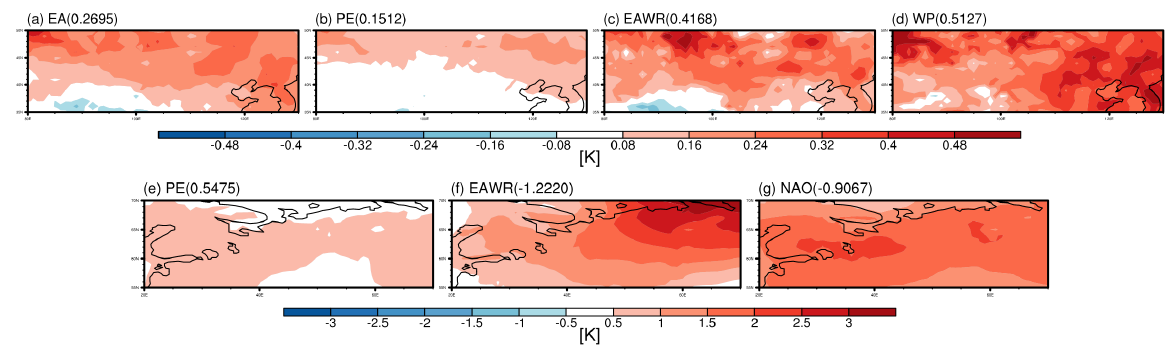
Figure 4. The spatial distribution of surface temperature (T2m, K) regressed on the principal com- ponent (PC) time series of the most related teleconnection patterns to the East Asia (EA) domain ( a – d ). Image ( e – g ) are the same as ( a – d ), except they are for the Northern Europe (NE) domain. The coefficient of the predictor for each related teleconnection pattern determined by the MLR model is in parentheses.